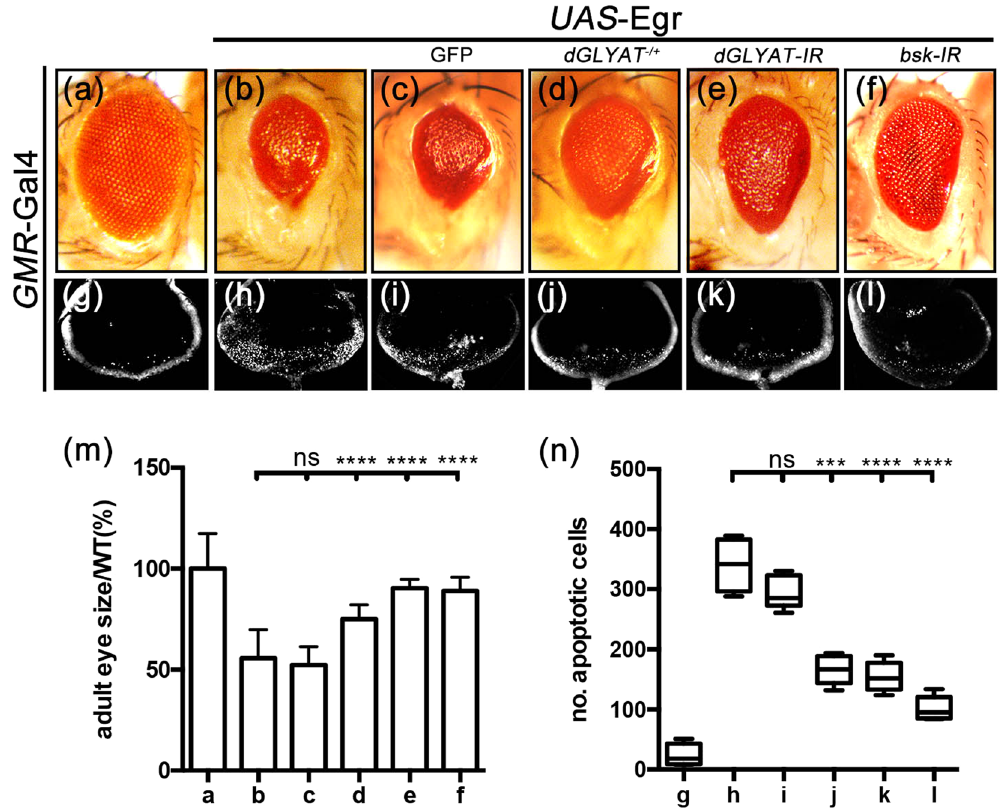
Figure 1. Loss of dGLYAT suppresses ectopic Egr-induced cell death in eye development. Light micrographs of Drosophila adult eyes ( a–f ) and fluorescent micrographs of third instar eyes discs ( g–l ) are shown. Compared with the GMR -Gal4 controls ( a,g ), GMR > Egr induces a small eye phenotype in adults ( b ) and massive cell death in 3 rd instar larval eye discs with AO staining ( h ). Both phenotypes are suppressed by mutation ( d,j ) or RNAi-mediated depletion ( e , k ) of dGLYAT , but remains unaffected by expressing GFP ( c , i ). Expression of bsk-IR serves as a positive control ( f , l ). ( m ) Statistics of eye sizes shown in ( a – e ) (a, n = 15; b, n = 11; c, n = 26; d, n = 20; e, n = 13; f, n = 14). ( n ) Statistics of AO-positive cell numbers shown in ( g – l ) (g, n = 5; h, n = 6; i, n = 12; j, n = 7; k, n = 7; l, n = 8). n.s., P > 0.05; **** P < 0.0001; *** P <